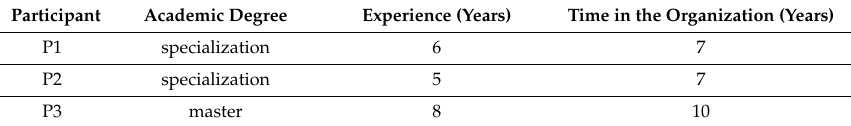
Table 3. Specialists profile who participated in the approach elaboration.